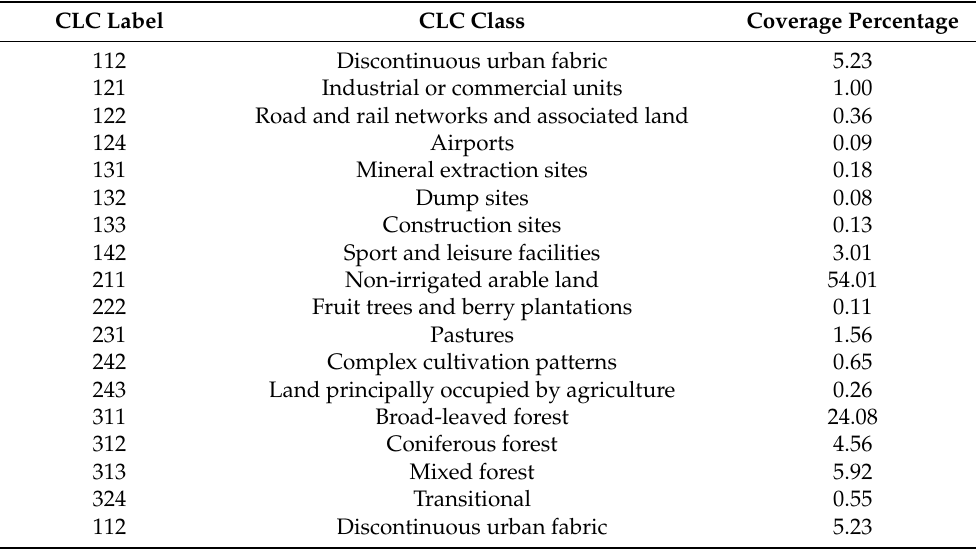
Figure 5. Soil use based on CLC [19] visualized together with the 122 1st-order catchments within the Nonette catchment. Table 5. Details of the CLC classes found within Nonette’s 122 1st-order